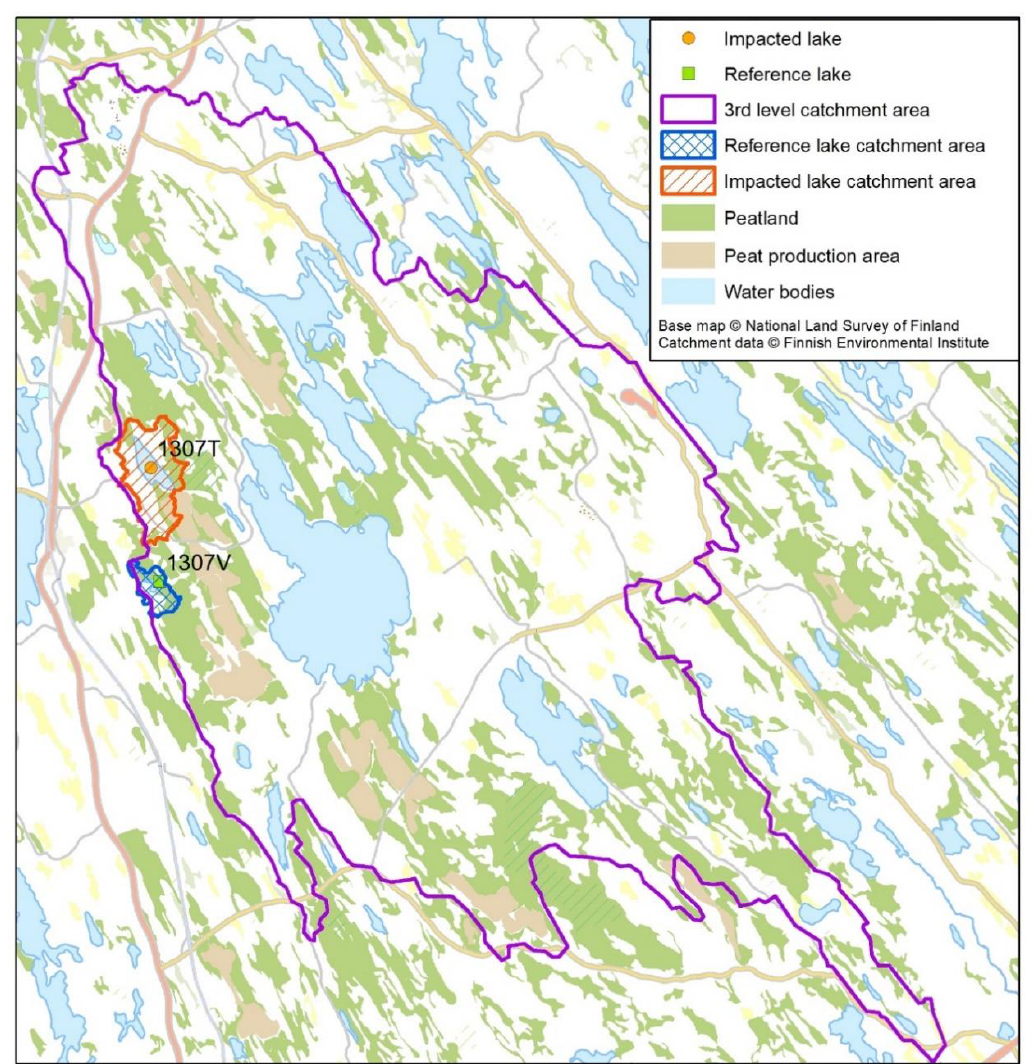
Figure 2. The boundaries and comparison of the 3rd level catchment area (purple line) and the lake upper catchment area (blue and orange raster). The 3rd level catchment area data are open-access, ready-to-use data [14], and the lake upper catchment areas was modelled with the VALUE-catchment delineament tool [16].